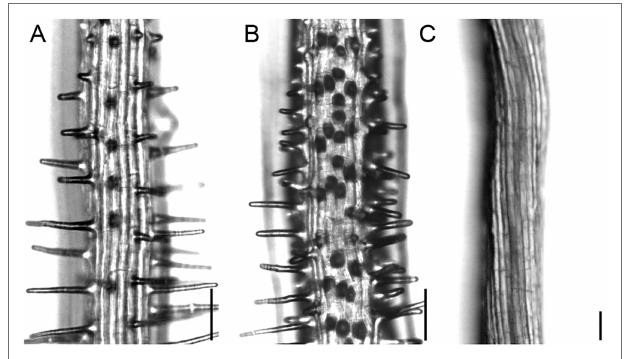
FIGURE 2 | Root hair patterning phenotypes in A. alpina. Light microscopic images of (A) wild type, (B) increased root hair number (line 1,264), (C) no root hairs (line 1,101). Scale bar: 100 mm.